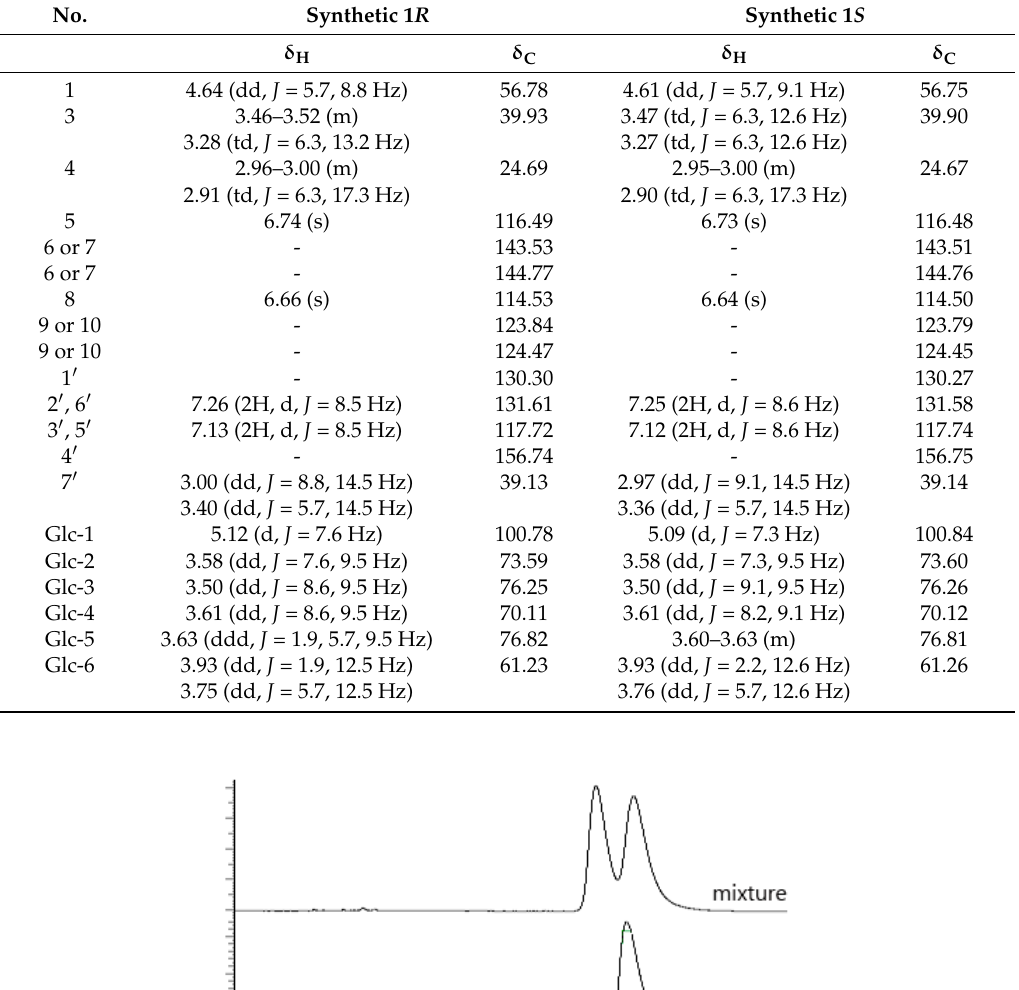
Table 1. NMR data for synthetic 1 R and 1 S in deuterium oxide.